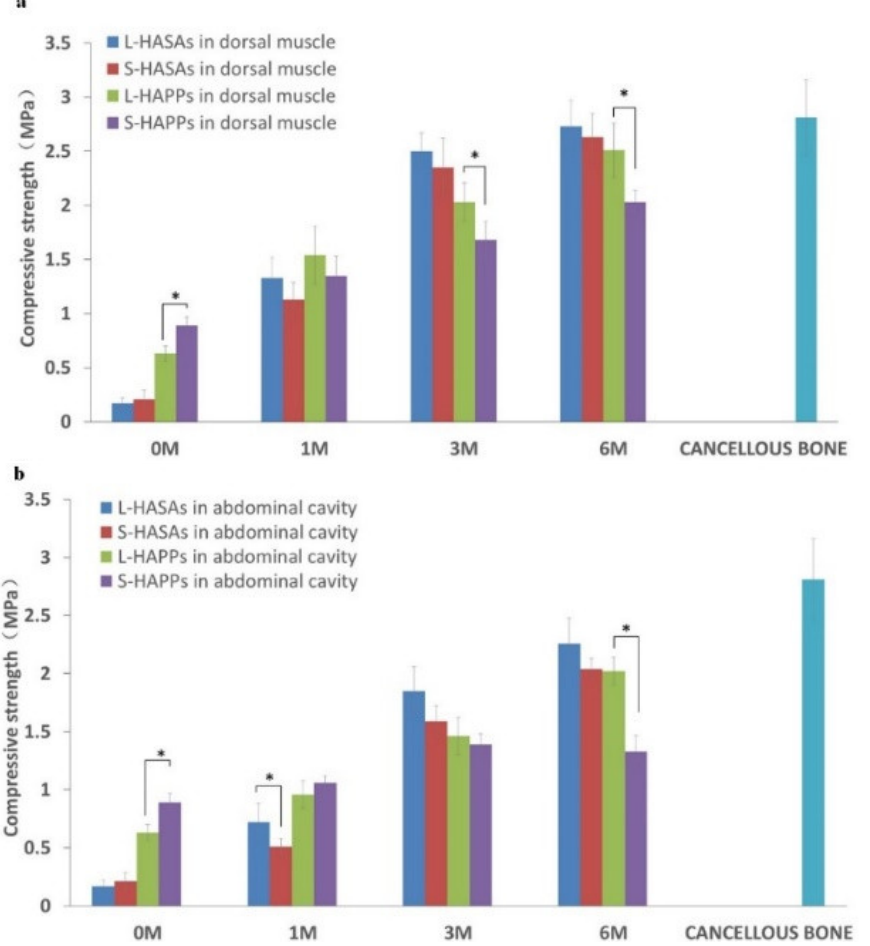
Figure 5. The compressive strength in HA porous scaffolds with different macropore sizes implanted in dorsal muscle ( a ) and abdominal cavity ( b ) (* p < 0.05).